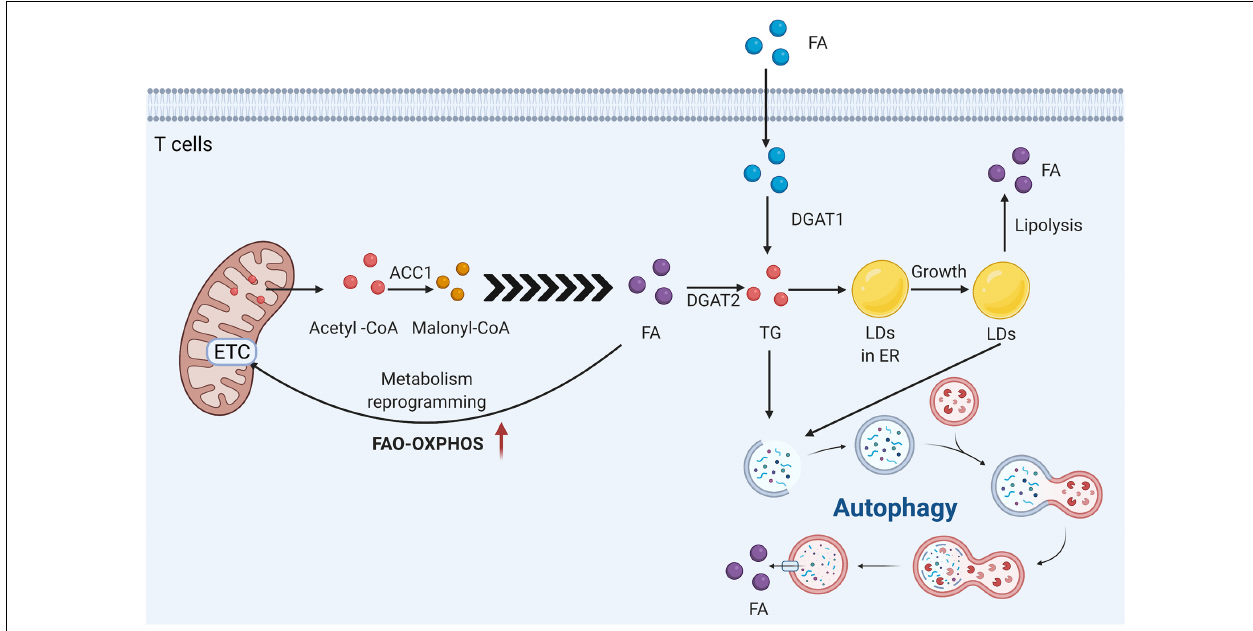
FIGURE 6 | T cells rely on the different aspects of lipid metabolism to develop function and differentiation. Acetyl-Coenzyme A carboxylase 1 (ACC1) is the key for the fatty acid generation in T cells. It can convert Acetyl-CoA into Malonyl-CoA. LDs are derived from the endoplasmic reticulum, and DGAT1 and 2 esterify free acylated fatty acids to diacylglycerols to form more inert triacylglycerols, which are stored in the LDs core. DGAT1 is responsible for the esterification of mainly exogenous fatty acids into TG, while DGAT2 is considered to have advantages in the esterification of endogenous synthetic FA. In general, there are three non-mutually exclusive intracellular mechanisms to avoid the toxic effects of acylated long-chain fatty acids: conversion to triglycerides and storage as LDs, increased β -oxidation in the mitochondria, and removal via